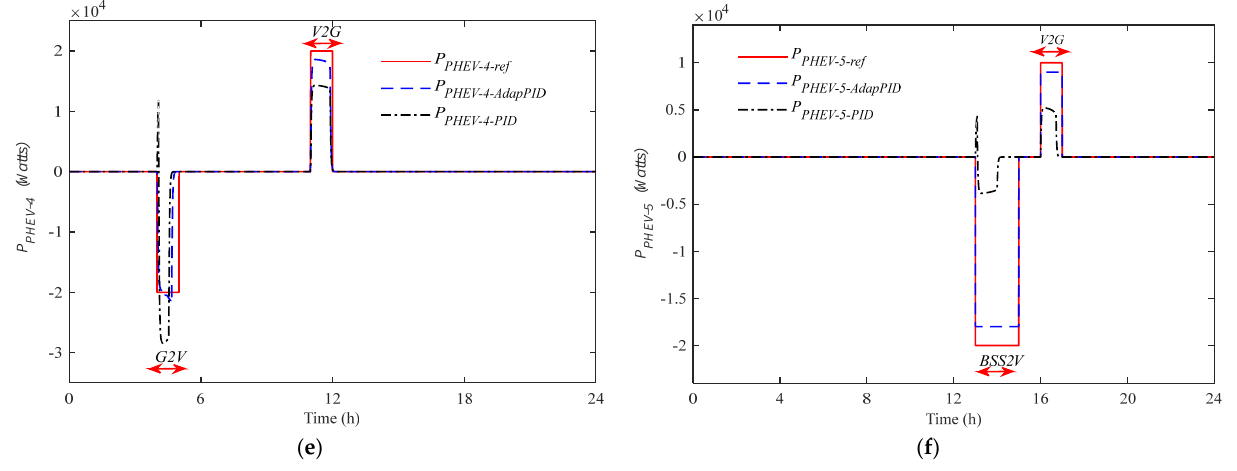
Figure 6. Power of ( a ) BSS ( b ) PHEV ‐ 1 ( c ) PHEV ‐ 2 ( d ) PHEV ‐ 3 ( e ) PHEV ‐ 4 ( f ) PHEV ‐ 5 .